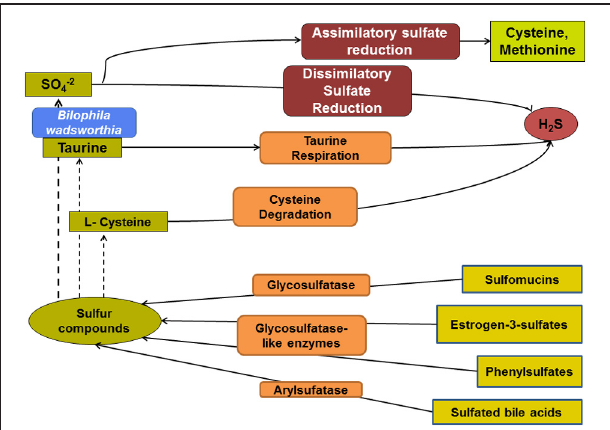
FIGURE 1 | Overview of the microbial pathways involved in colonic sulfur metabolism. The sulfate remaining from assimilatory sulfate reduction is available for sulfate-reducing bacteria and, thus, H 2 S production. Taurine and cysteine are additional potentially important substrates for microbial production of H 2 S. Various microbial metabolic pathways influence the composition and relative abundance of organic sulfur compounds.